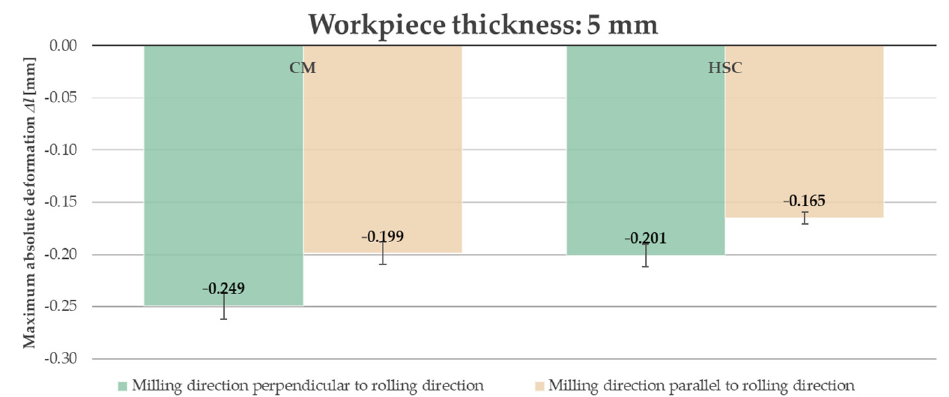
Figure 14. Comparison of the maximum absolute deformations Δ l depending on the ratio of the milling direction to the rolling direction for the semi-finished product with a thickness of 12 mm.